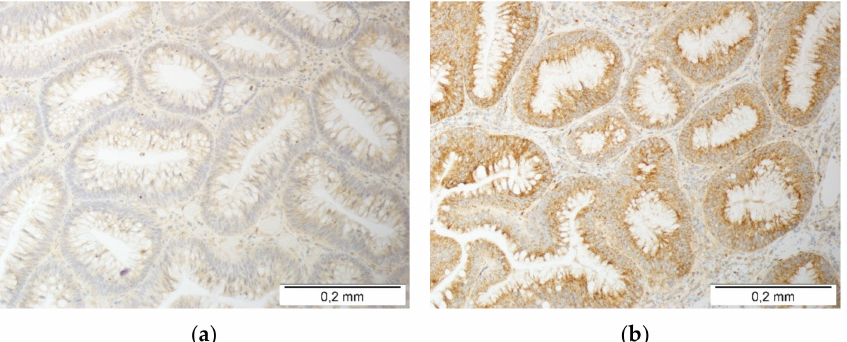
Figure 2. Immunohistochemical analysis of MCP-3/ CCL7 protein expression in colorectal adenomas: ( a ) a weak cytoplasmic reaction, or the reaction did not encompass the entire lesion (score 1; +)